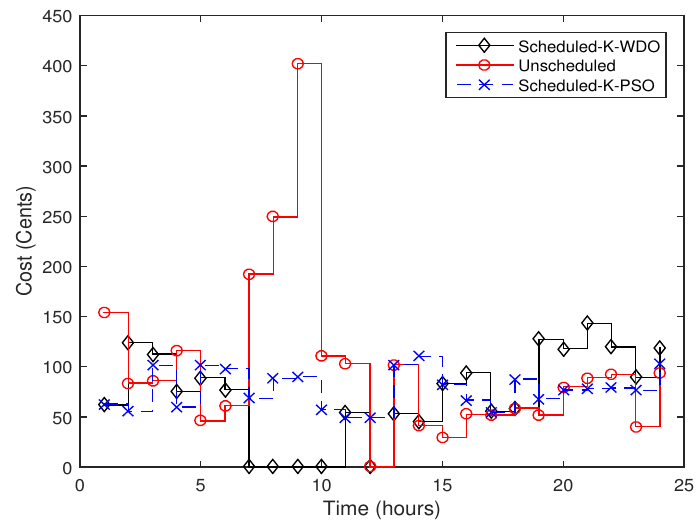
Figure 9. Electricity cost comparison of using the knapsack WDO (K-WDO) and K-PSO